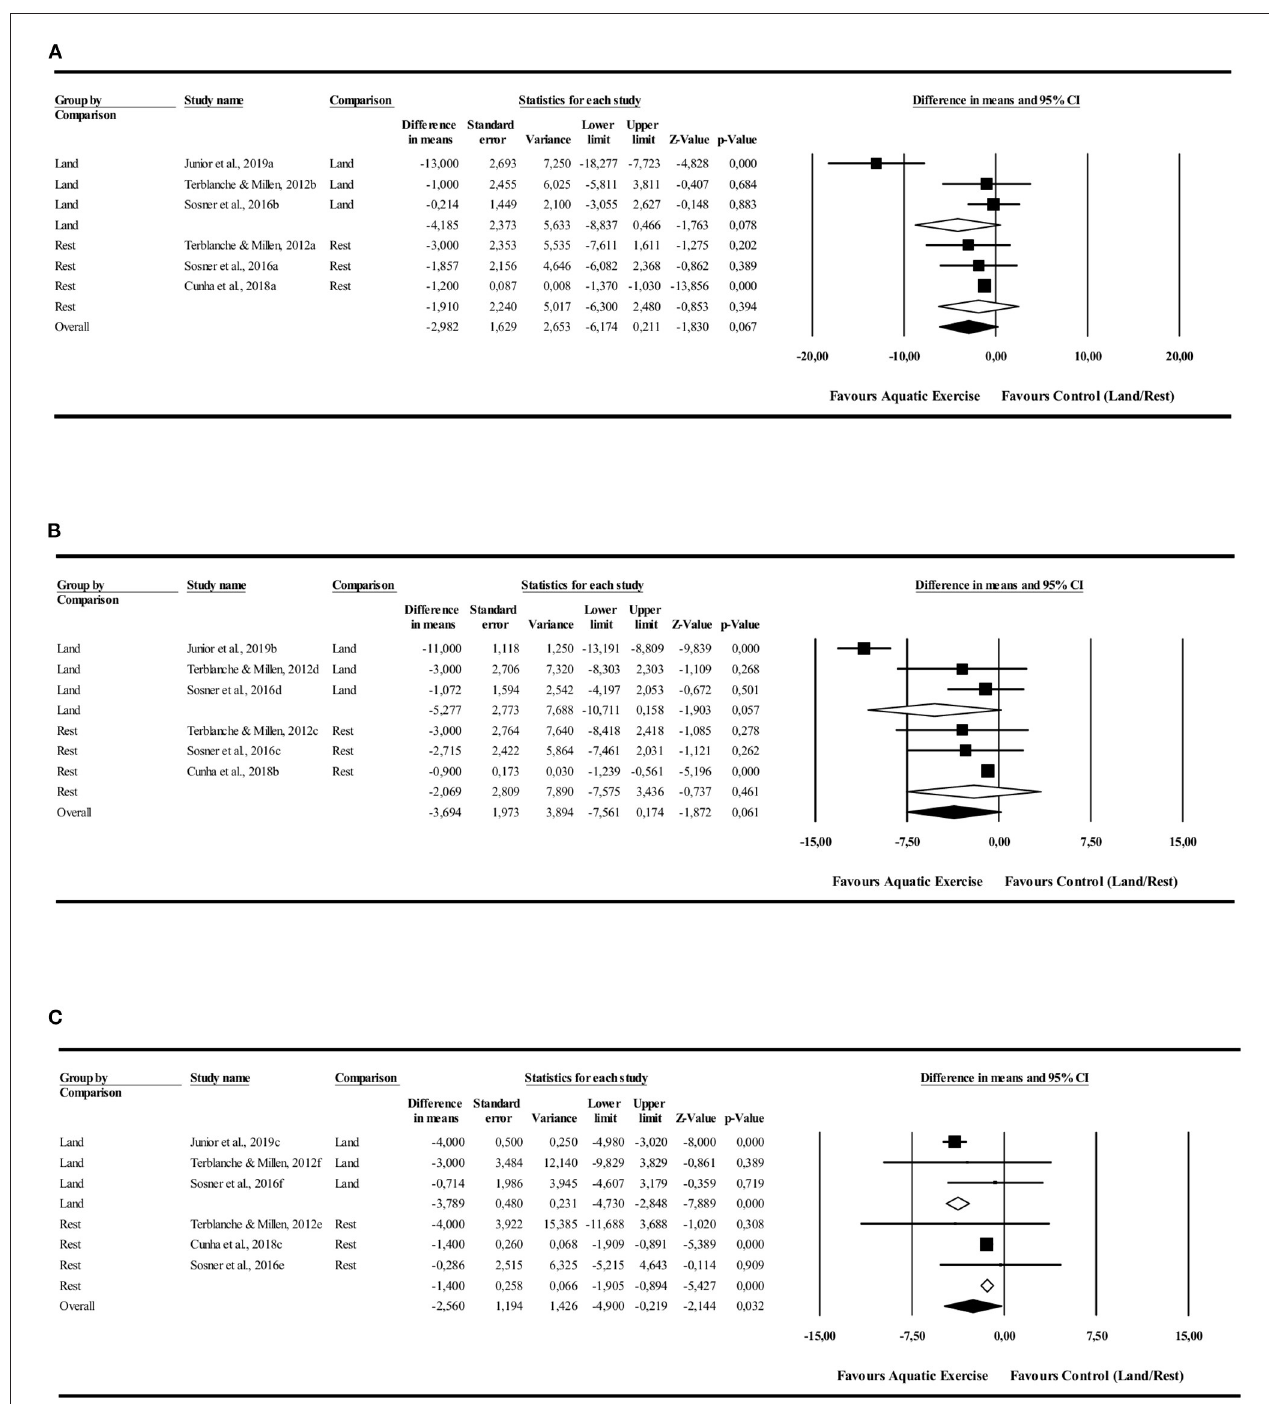
FIGURE 3 | Diastolic blood pressure post-exercise hypotension effect. Comparison between water exercise (aquatic) with land exercise or rest condition. (A) 24h, (B) Daytime, (C) Nighttime.